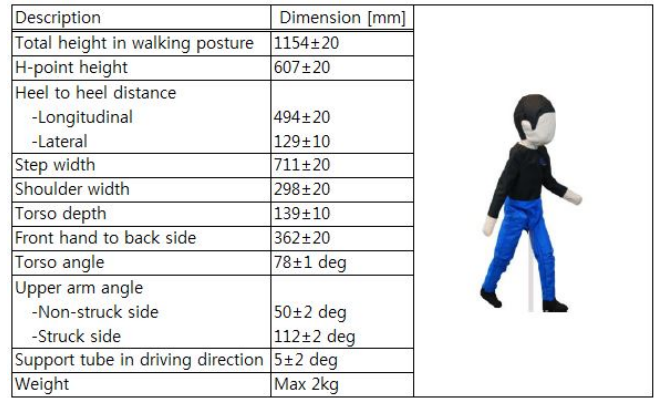
Figure 8. Euro NCAP adult pedestrian target.